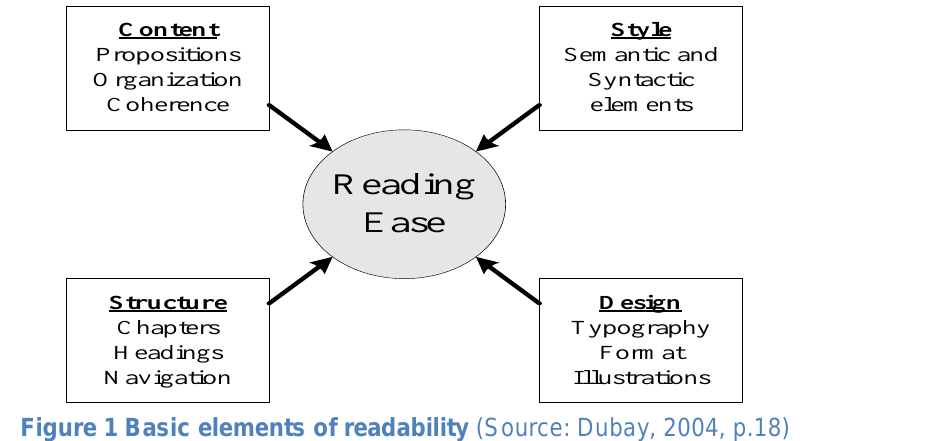
Figure 1 Basic elements of readability (Source: Dubay, 2004,